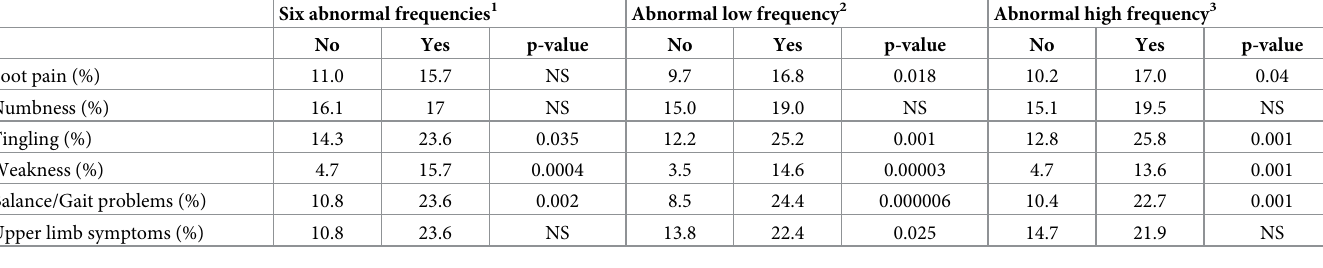
Table 6. Frequency of neuropathic symptoms with three different combinations of abnormal